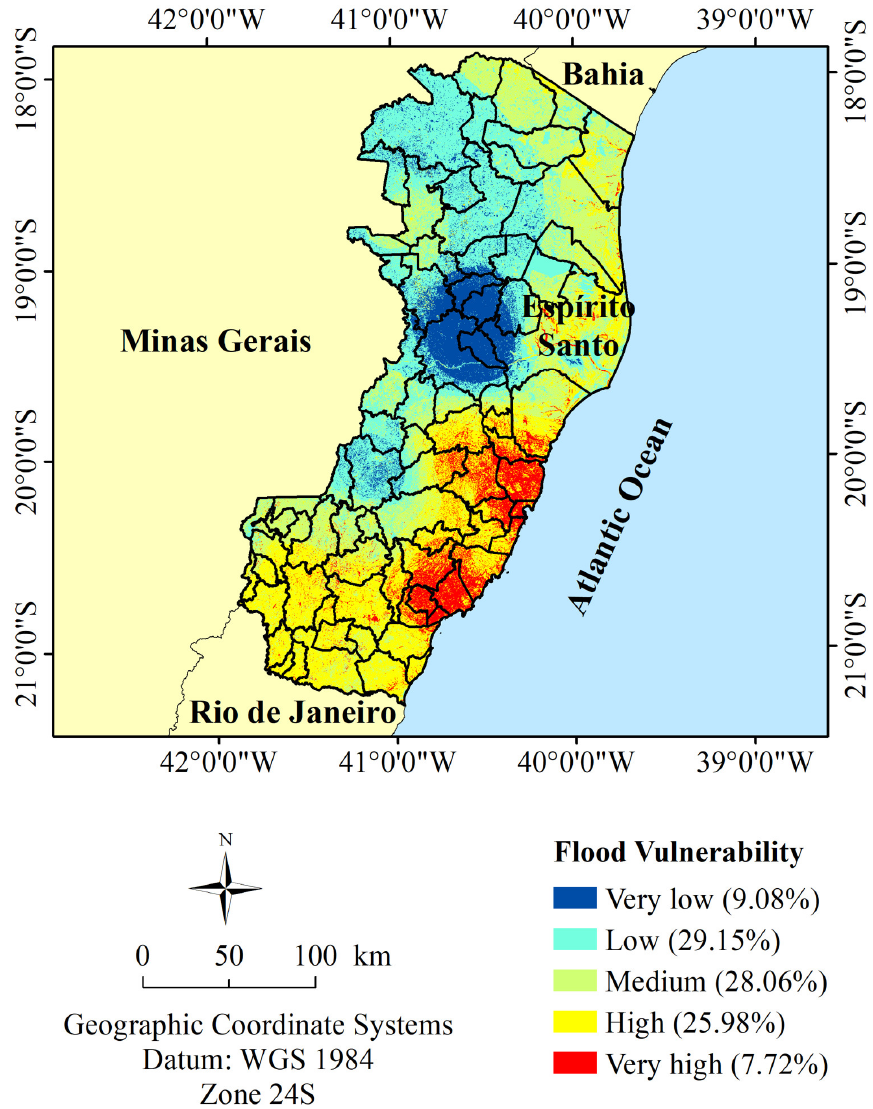
Figure 9. Annual flood vulnerability for Espírito Santo state.